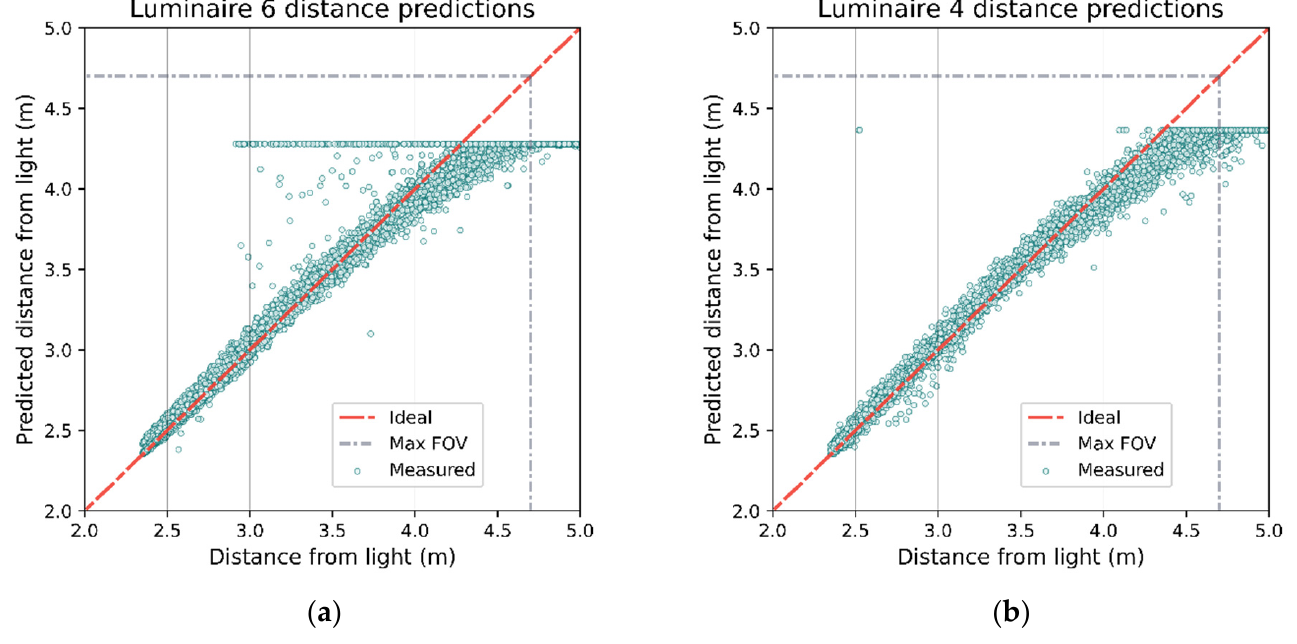
Figure 20. Actual distances to luminaire vs. distances expected based on RSS model for luminaires 4 and 6. Both luminaires demonstrate linear behavior up until the photodiodes begin to reach their FOV (grey dashed line). The pillar near luminaire 6 causes a cluster of points that clearly violate the model ( a ) where the predicted distance is greater than the actual distance. The predicted distance for each luminaire will be limited due to the clamping of RSS (an example for luminaire 4 in ( b )).